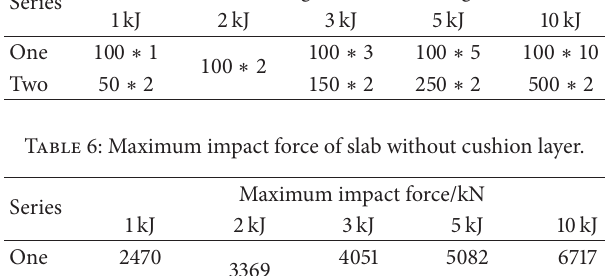
Figure 10: Contrast of force-time curves. Table 5: Rockfall configuration in simulation. Series